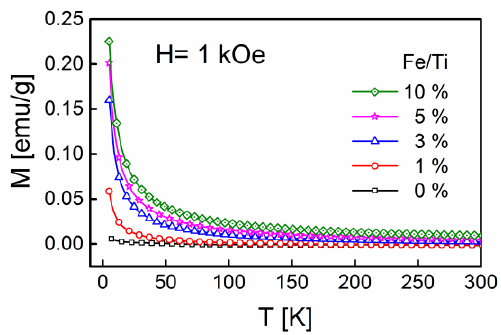
Figure 12. Temperature-dependent magnetizations measured under a constant magnetic field of 1 kOe.